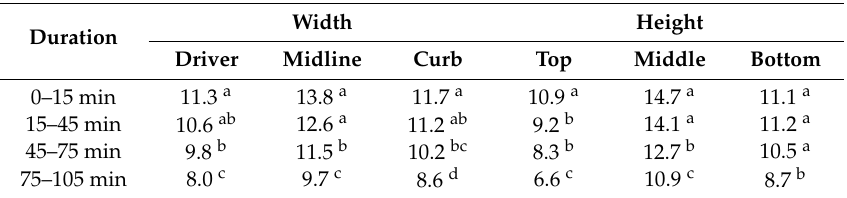
Table 6. The effect of trip duration on elevated temperature above ambient ( ∆ t, ◦ C) at measured locations across width and height of the trailer with plastic wrap ( n = 5).